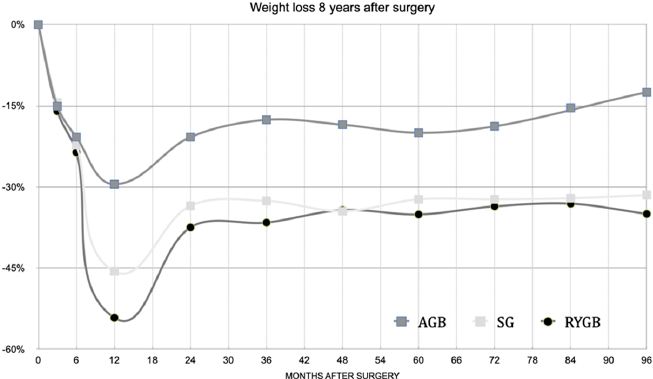
weight loss divided by excess weight based on ideal body weight at BMI 25 kg/m 2 , was 60.6% ± 32.3 from baseline to 8 years after surgery. RYGB patients had the greatest weight loss of 50.3 ± 28.8 kg (%EWL = 71.7 ± 27.4%) at the end of follow-up period, although this not dissimilar to that observed in SG patients (45.6 ± 27.8 kg (%EWL = 70.0 ± 21.9%), AGB: Laparoscopic adjustable gastric banding SG: Sleeve gastrectomy. RYGB: Roux-en-y gastric whereas weight loss in AGB patients was lower (17.6 ± 22.5 kg; %EWL = 22.9 ± 32.3%). (Table 2) Three subjects, all belonging to the AGB group, completely regained their weight loss (WL) over the whole sample.